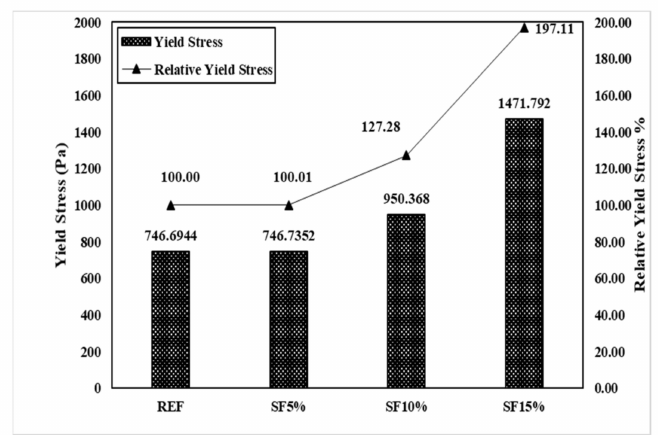
Figure 20. Yield stress ( τ 0 ) of the mixing ratio (Jeon’s data).